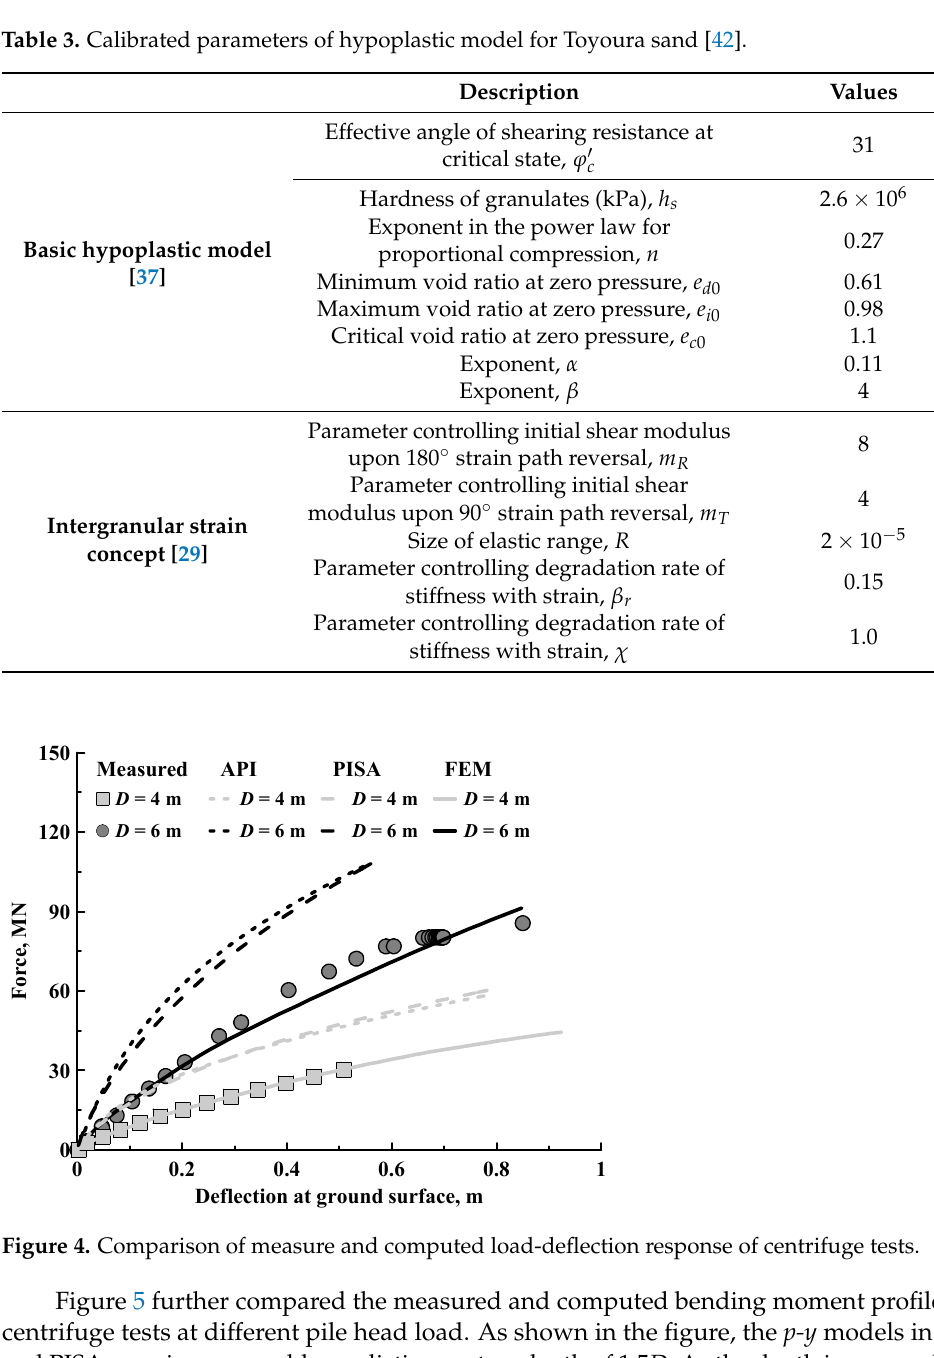
p-y models will highly underestimate the bending moment with a much shallow depth of zero moment. This suggested that the p-y curves at deep zones are not well modelled. On the contrary, the FE model using the hypoplastic model for sand can well capture the bending moment profile for both diameter monopiles under different